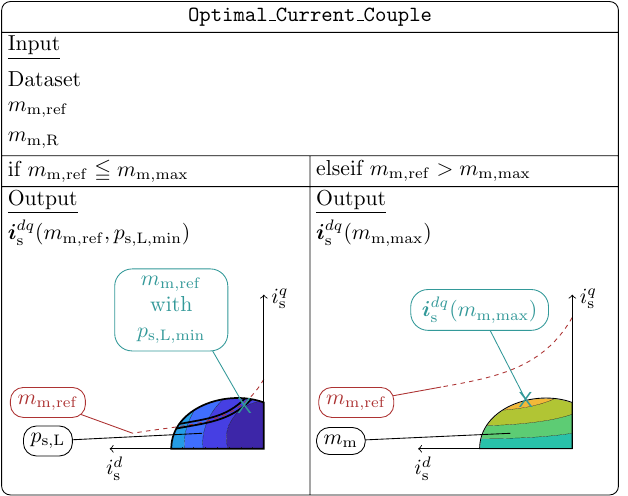
Figure 13. Illustration of subroutines Optimal_Current_Couples with input m = i dq and output i dq s : If m m,ref is feasible, the current couple is returned which minimizes losses s,ref (see left X); if m m,ref is not feasible the current couple is returned which maximizes the torque (see right